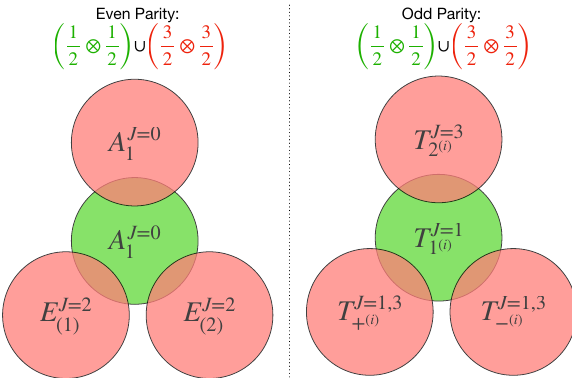
⊗ 3 ⊗ 1 and 1 electrons, 2 2 2 2